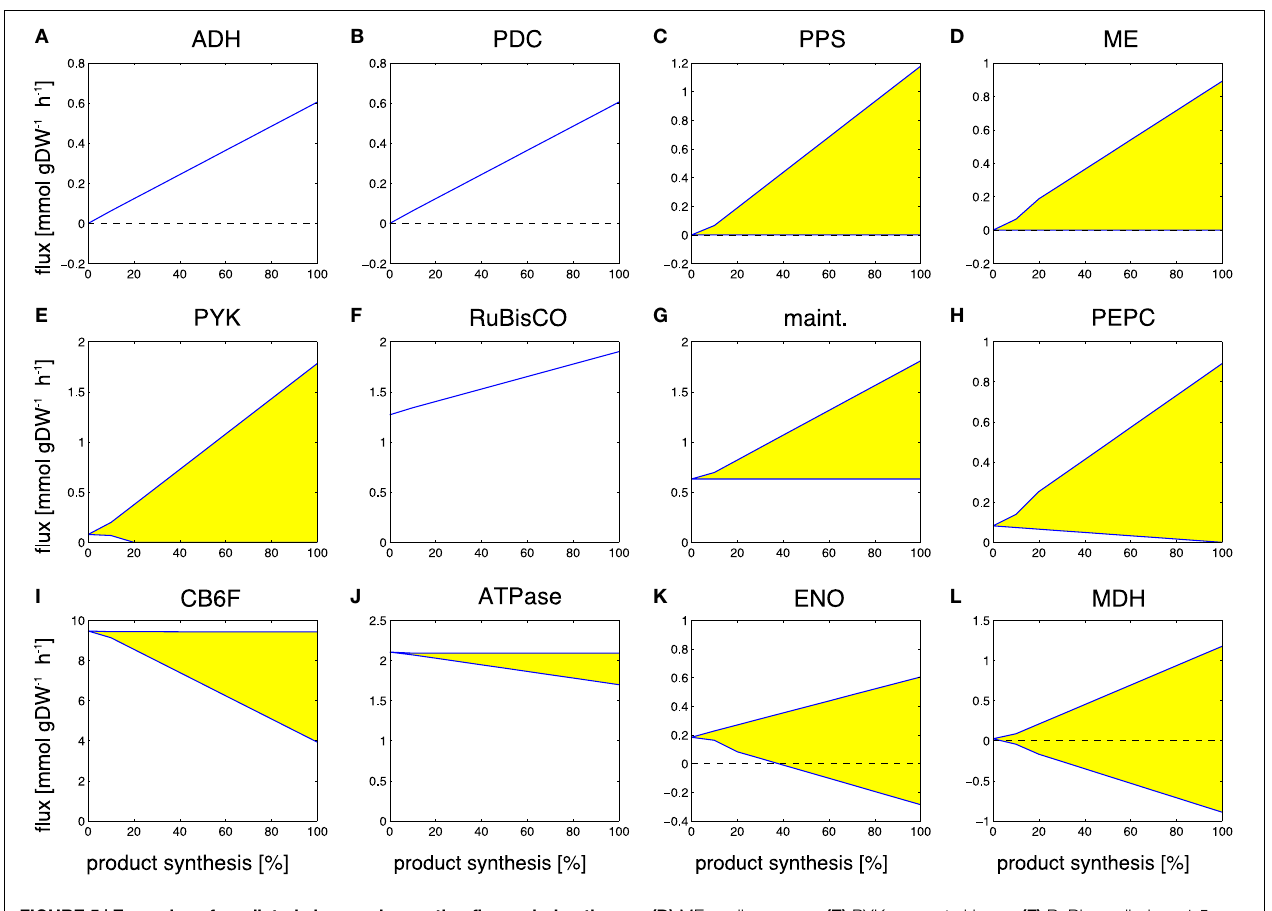
FIGURE 5 | Examples of predicted changes in reaction fluxes during the transitions from growth-only phenotype to production-only phenotype for ethanol . Yellow areas correspond to flux variability, the predicted flux may attain any value within these areas. Abbreviations: (A) ADH, alcohol dehydrogenase; (B) PDC, pyruvate decarboxylase; (C) PPS, PEP synthase;